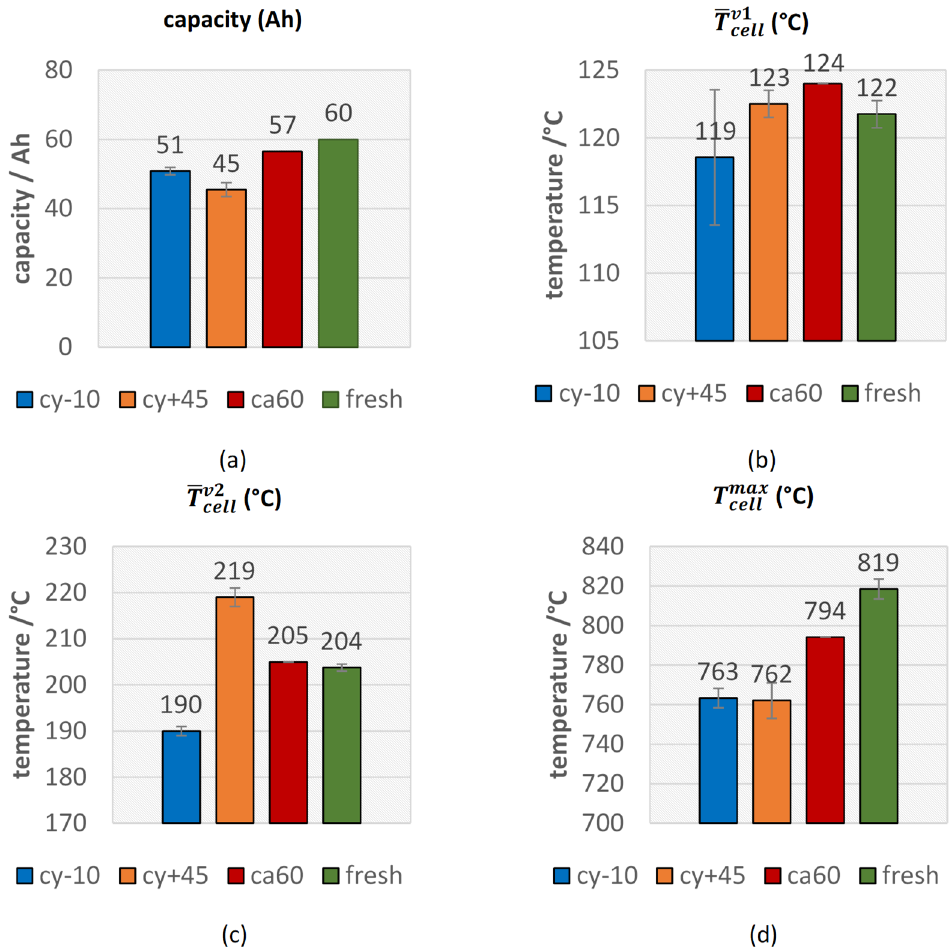
Figure 3. Comparison of safety relevant thermal parameters in overtemperature triggered TR of fresh (green) and aged (cy − 10: blue, cy+45: orange, ca60: red) #1 cells. ( a ) The measured capacity of the cells immediately before the TR experiment; the average cell surface temperature at ( b ) the first venting and at ( c ) the second venting; ( d ) the maximal measured temperature on the cell